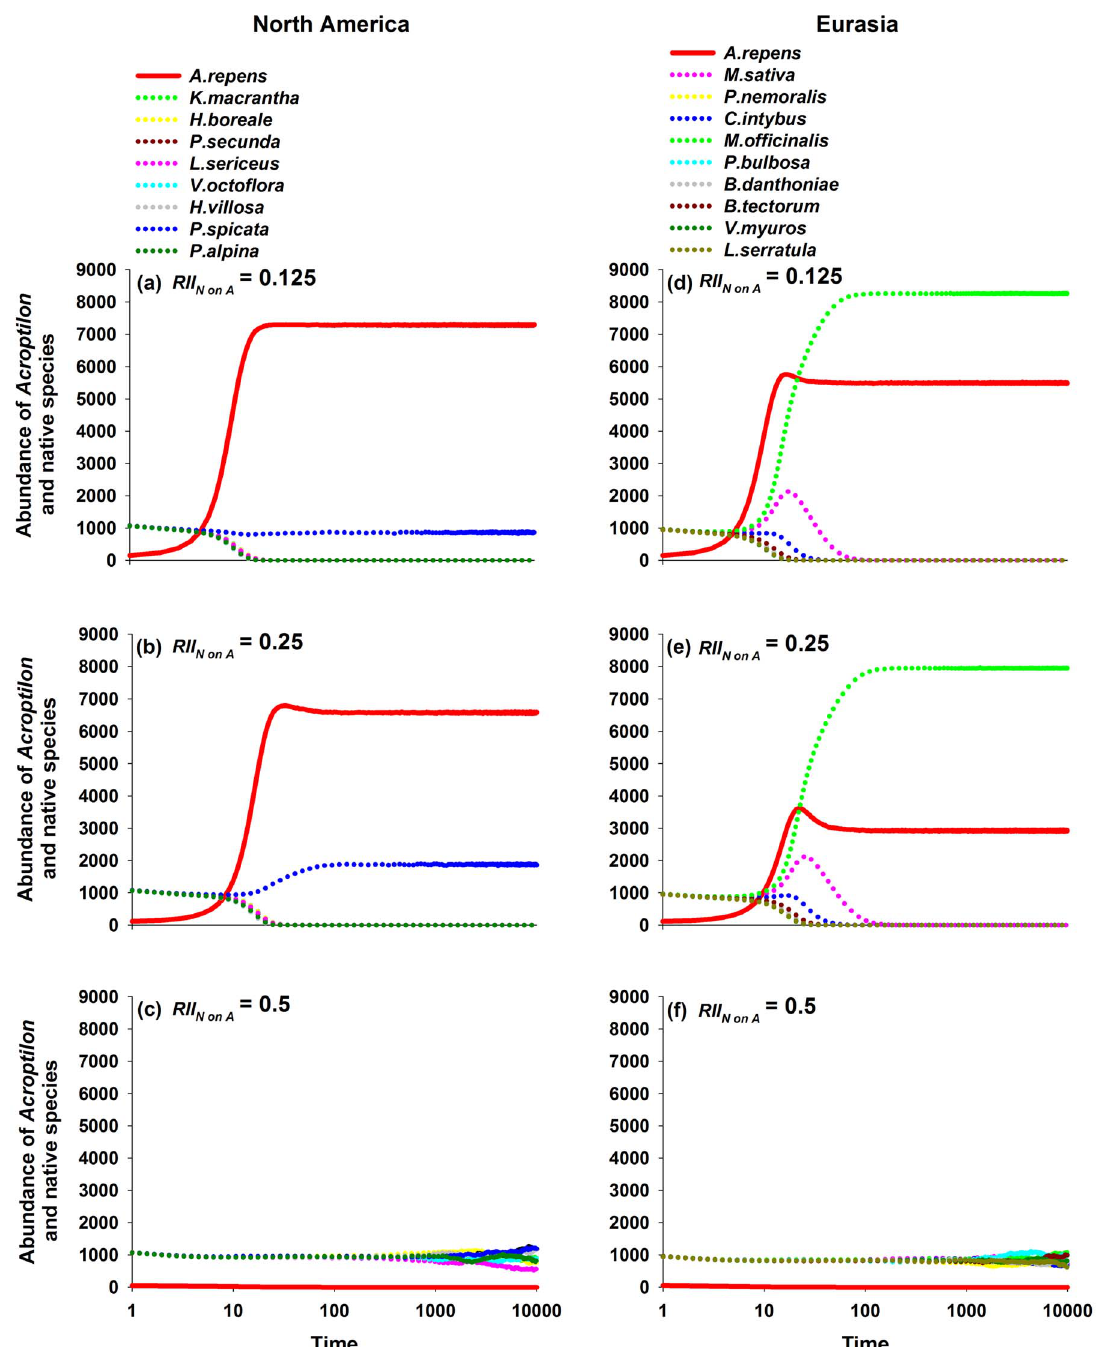
Figure 2. Abundances of Acroptilonrepens and native species through time under different competitive scenarios. Abundances of Acroptilon repens and native species through time under different competitive scenarios for the native and non-native range of the invader. Acroptilon is represented by a solid line and native species are represented by dotted lines. Note the log scale on the x-axis.